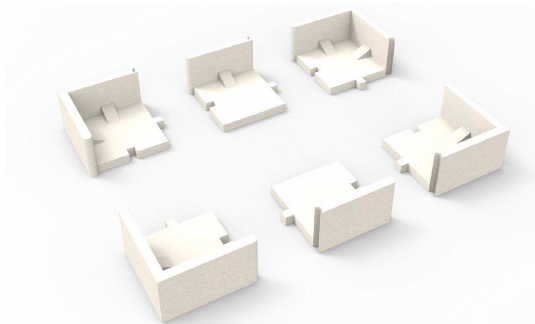
Figure 24. Design of dovetail technique.